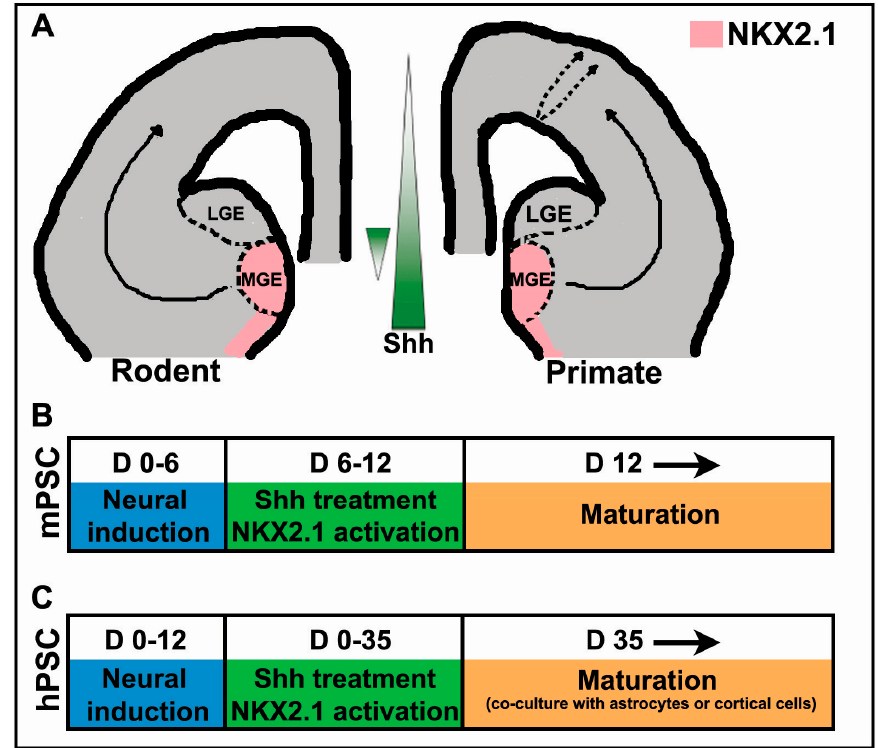
Figure 1. Sonic hedgehog (Shh)-dependent in vivo and in vitro cortical interneuron progenitor specification and maturation. ( A ) Schematic illustration of interneuron fate specification in vivo in the rodent and primate model. Shh signaling is highest in the developing ventral forebrain in contrast to a reversal in this gradient within the medial ganglionic eminence (MGE). Black solid arrows represent established tangential migrations of inhibitory progenitors derived from the MGE and dashed arrows indicate a proposed dorsal niche generating a subset of GABAergic progenitors that move radially to the neocortex. The shaded pink area represents NKX2.1 expression within the ventral telencephalon; ( B , C ) mouse (mPSC) and human pluripotent stem cells (hPSC) differentiation timelines (in days (D)) for deriving GABAergic interneurons in vitro.